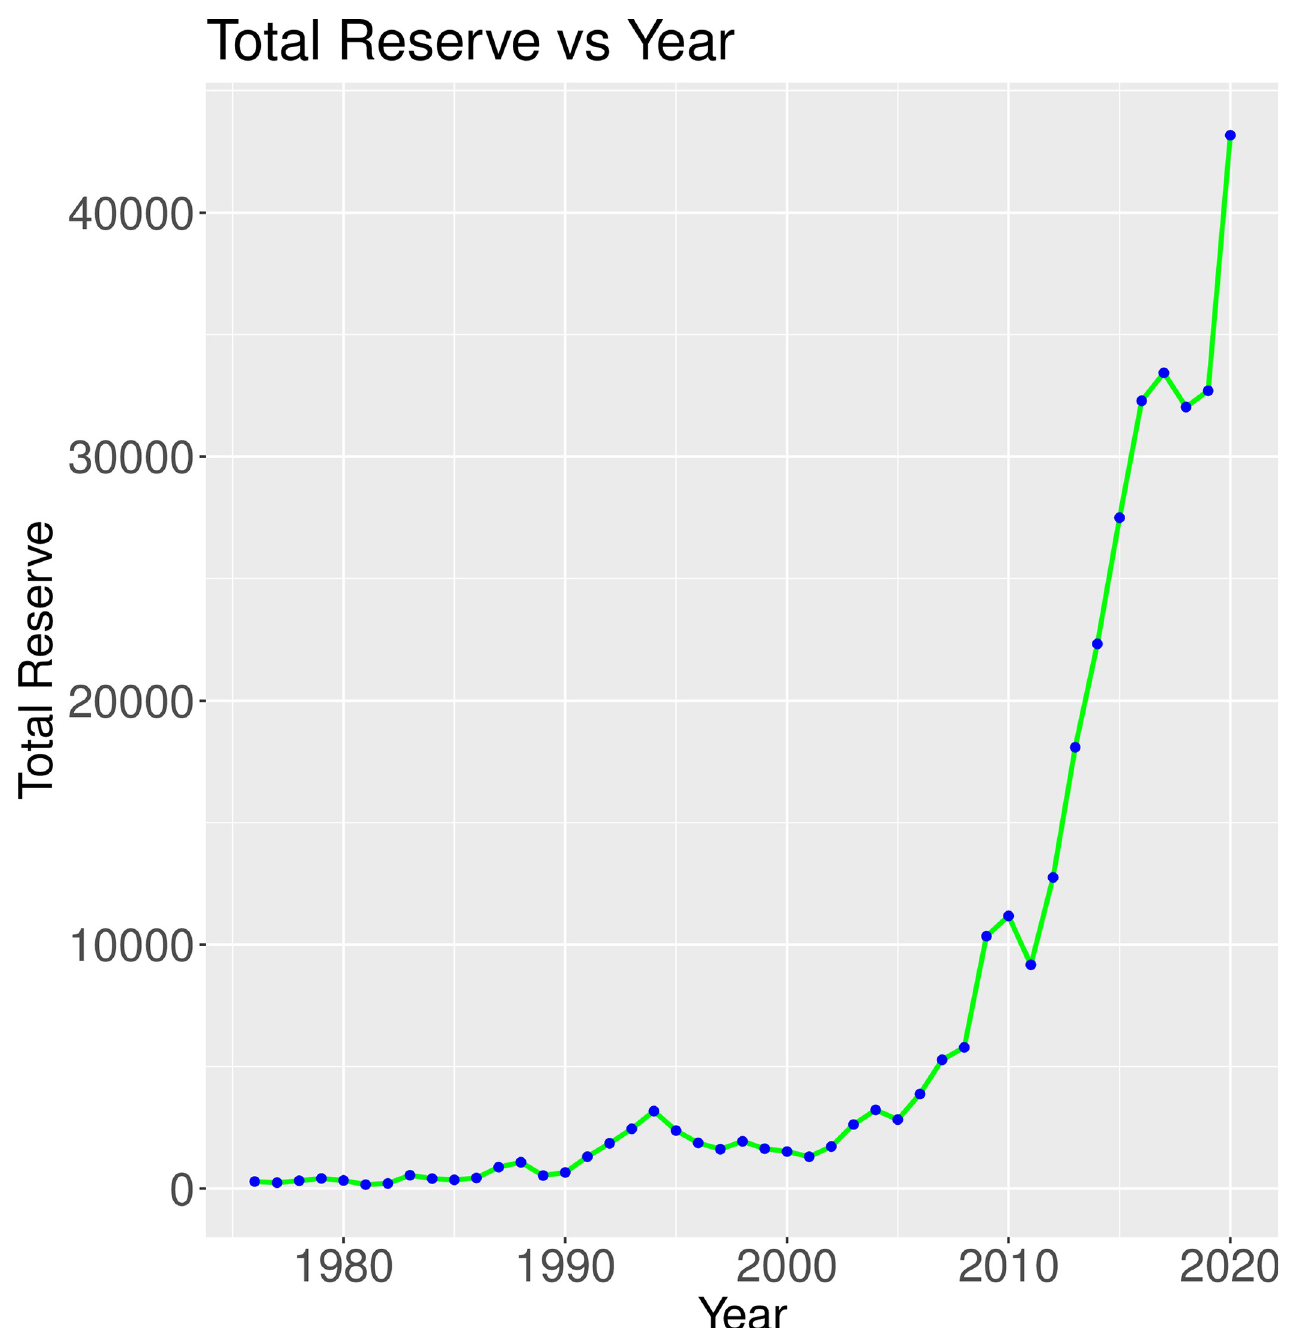
Fig 2. Time series plot of the response variable (total